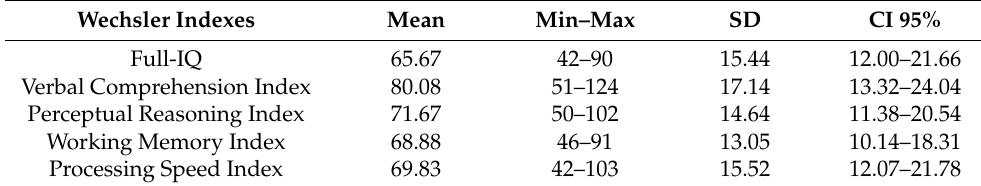
Table 3. Cognitive abilities of children and adolescents with KBG syndrome. Figure 1. Panel a , b Mean of standard scores in Wechsler scale ( a ) and domains of adaptive behaviour ( b ). VCI verbal comprehension index; PRI perceptual reasoning index; WMI working memory index; PRI processing speed index; ** p ≤ 0.01; *** p ≤ 0.001.